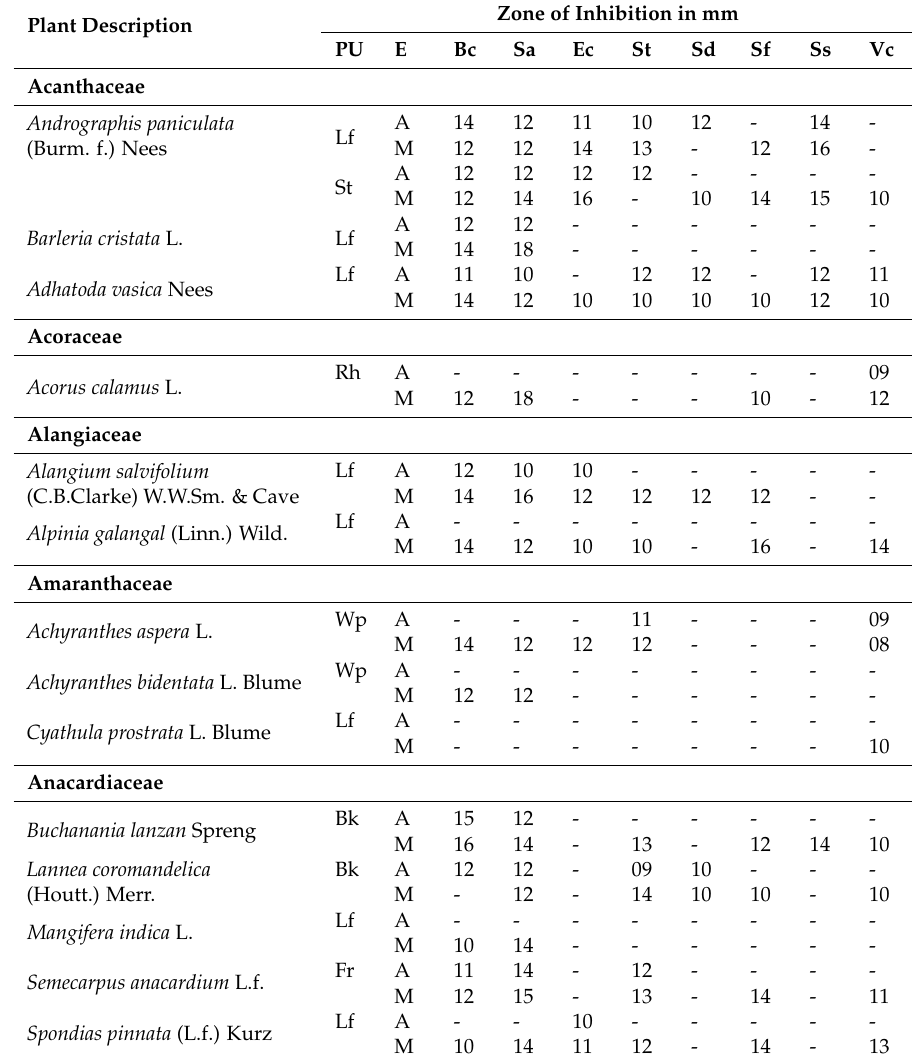
Table 2. Results of screening of plants from Northern Odisha,